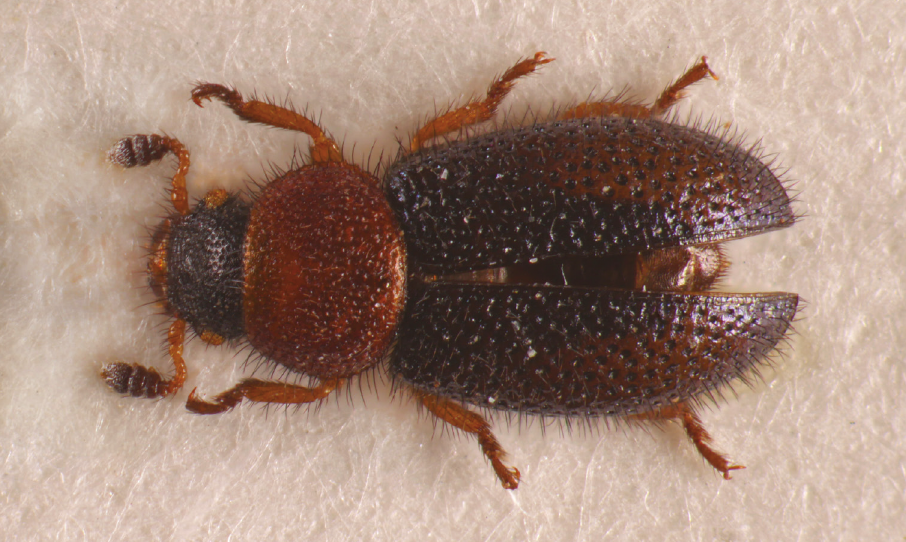
Figure 3. Habitus of the first record of Opetiopalpus sabulosus Motschulsky, 1840. Multiple photographs were taken using a stereo microscope (Olympus ZX 10) and a camera (Panasonic Lumix GH4), and rendered with a focus stacking software (Helicon Focus version 6.0) by Andreas Eckelt. The specimen is stored in the collection of Manfred Kahlen at the “Tiroler Landesmuseen Betriebs G.m.b.H.,